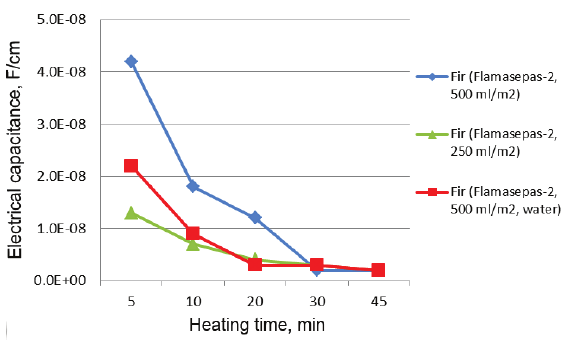
fig. 7. the dependency of the average electrical capacitance on heating time for media 12, 13 and 14